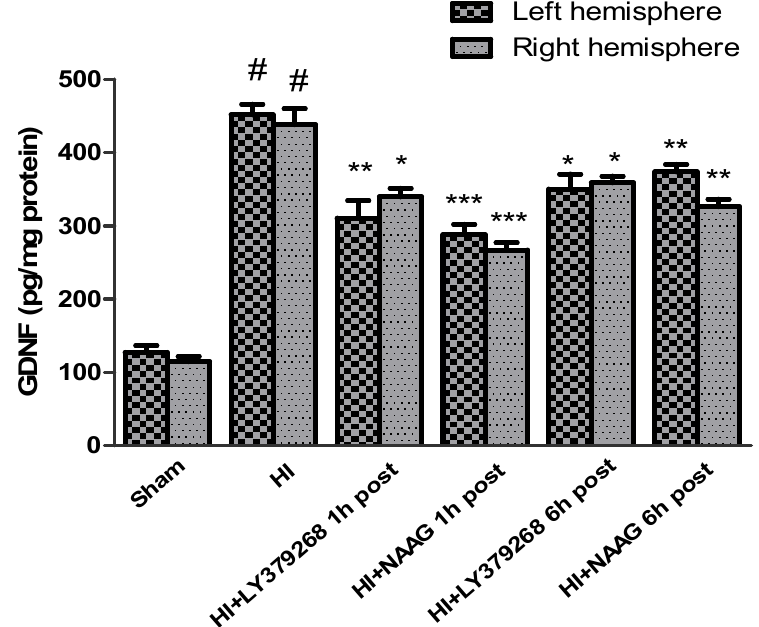
Figure 4. Effect of mGluR2 or mGluR3 agonists injection on GDNF level. Results are presented as mean ± SEM, n = 6–8; statistically significant differences: * p < 0.05, ** p < 0.01, *** p < 0.005—different from H-I; # p < 0.001—different from sham operated group.